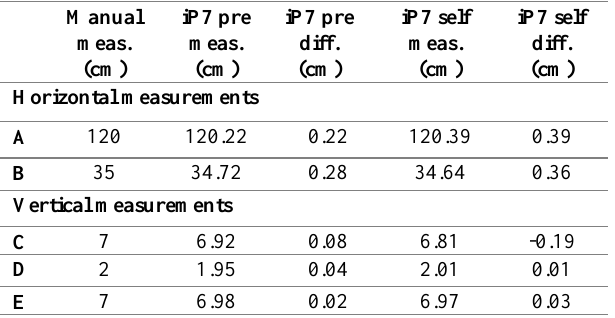
Table 4. Dimensions of curb ramp parameters of interest using 3D point clouds generated with reduced set of images from iPhone 7; pre-calibrated camera parameters vs self-calibration procedure.